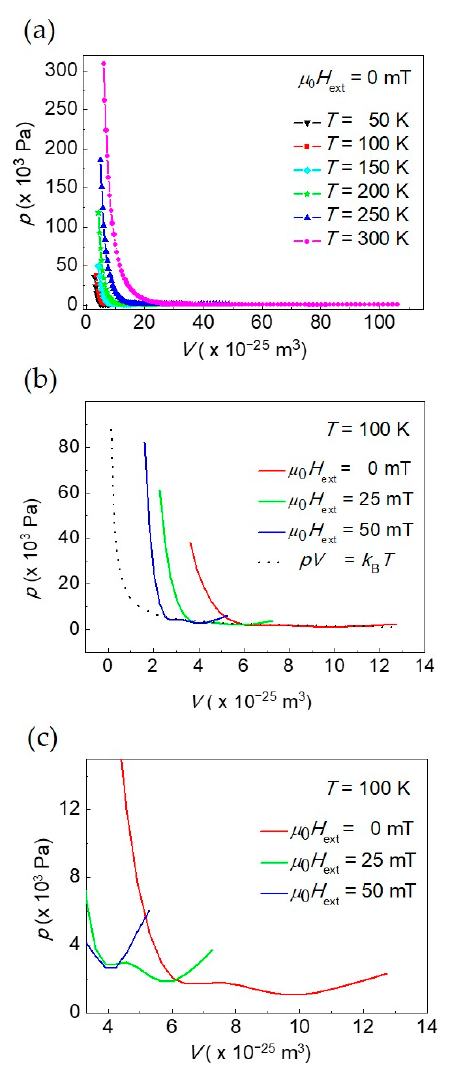
Figure 5. ( a ) Solid lines with symbols: pressure of the skyrmions population calculated according to Equation (29e) as a function of the skyrmion volume at different temperatures in zero applied magnetic field (black line with down triangles: T = 50 K, red line with squares: T = 100 K, cyan line with diamonds: T = 150 K, green line with stars: T = 200 K, blue line with up-triangles: T = 250 K, magenta line with circles: T = 300 K). ( b ) Solid lines: as in panel ( a ) but for T = 100 K and µ 0 H ext = 0 mT (red line), µ 0 H ext = 25 mT (green line), µ 0 H ext = 50 mT (blue line). Dotted line: pressure p = 1 / V k B T according to the ideal gas law for N = 1. ( c ) Pressure of the skyrmions population as a function of the skyrmion volume for T = 100 K and µ 0 H ext = 0 mT (red line), µ 0 H ext = 25 mT, µ 0 H ext = 50 mT for volumes V > < V >